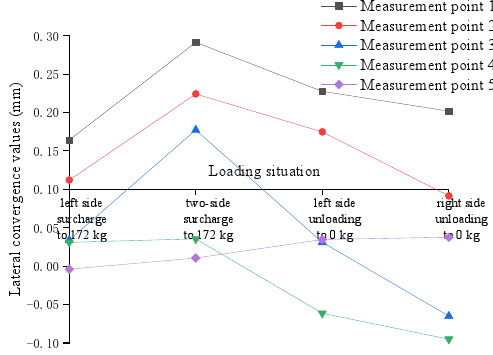
Figure 8. Transverse convergence variation of each measurement point with surcharge in Case 1.